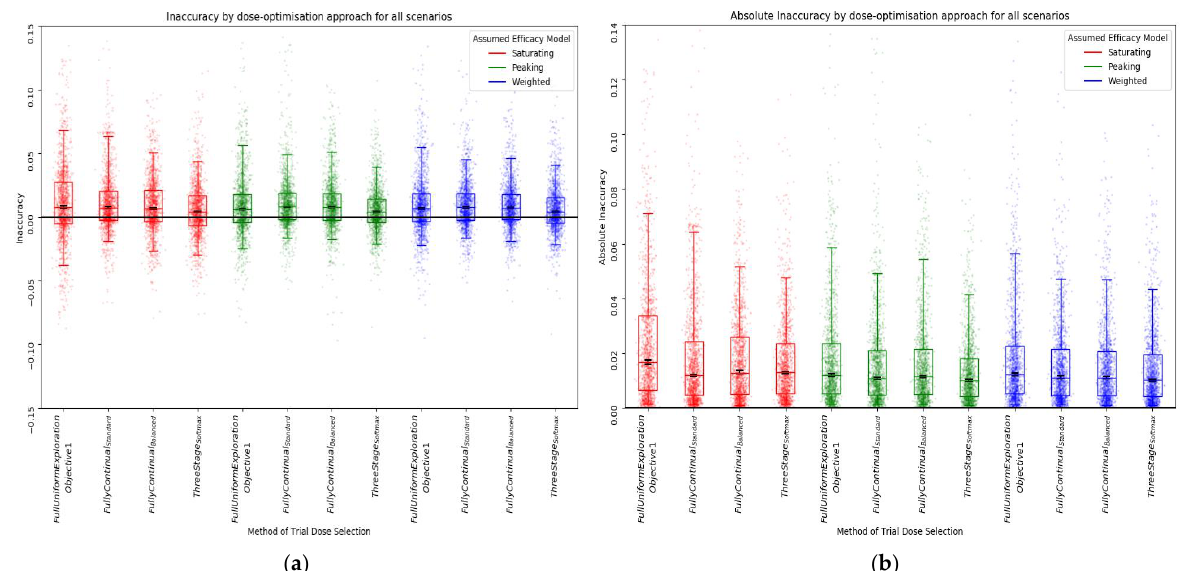
Figure 11. Inaccuracy ( a ) and absolute inaccuracy ( b ) for all scenarios by assumed efficacy model and trial dose-selection method. Trial size was 30. Individual points represent inaccuracy/absolute inaccuracy for a single simulated clinical trial using that dose-optimisation approach for one of the 14 scenarios. The middle line of each boxplot is the median value; the box marks the 25th and 75th percentiles, and the whiskers mark the 5th and 95th percentiles of the data. The closer inaccuracy/absolute accuracy is to 0, the more accurate the prediction of utility is at the predicted optimal dose. Black lines represent the 95% confidence interval for the median of each distribution [47]. The majority of these distributions of absolute inaccuracy were not different to a statistically significant extent at the p = 0.05 threshold according to the Kolmogorov–Smirnov test. For further details on statistical significance, see Supplementary S12.